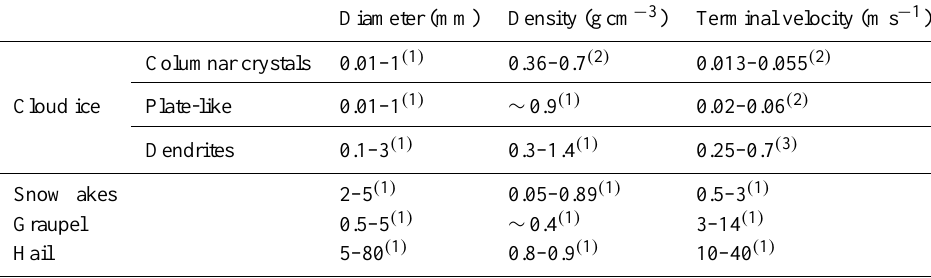
Table 1. Typical characterizations of the frozen hydrometeor